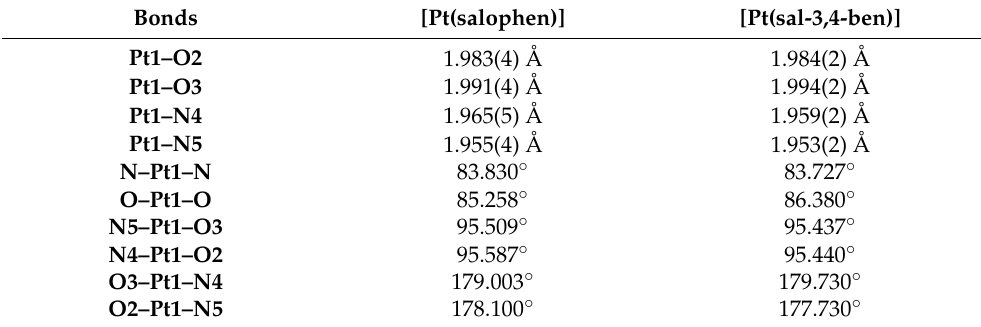
Table 1. Chemical bond distances to the coordination site, from the single-crystal X-ray data of